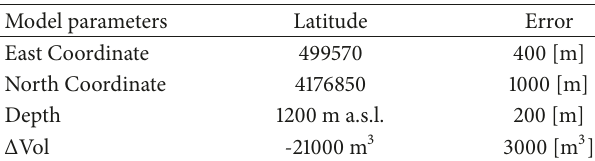
Table 3: Location and volume obtained through the point source